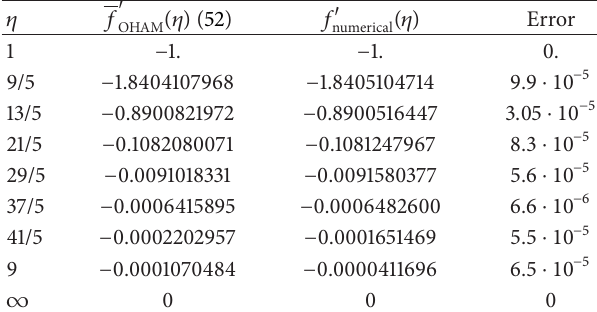
Table 6: Comparison between the first expression of the first-order approximate solutions 𝑓(𝜂) given by (51) obtained by OHAM and numerical results for 𝛾 = 1 and 𝑆 = −2 (error = | 𝑓 (𝜂)| ). 𝑓 numerical